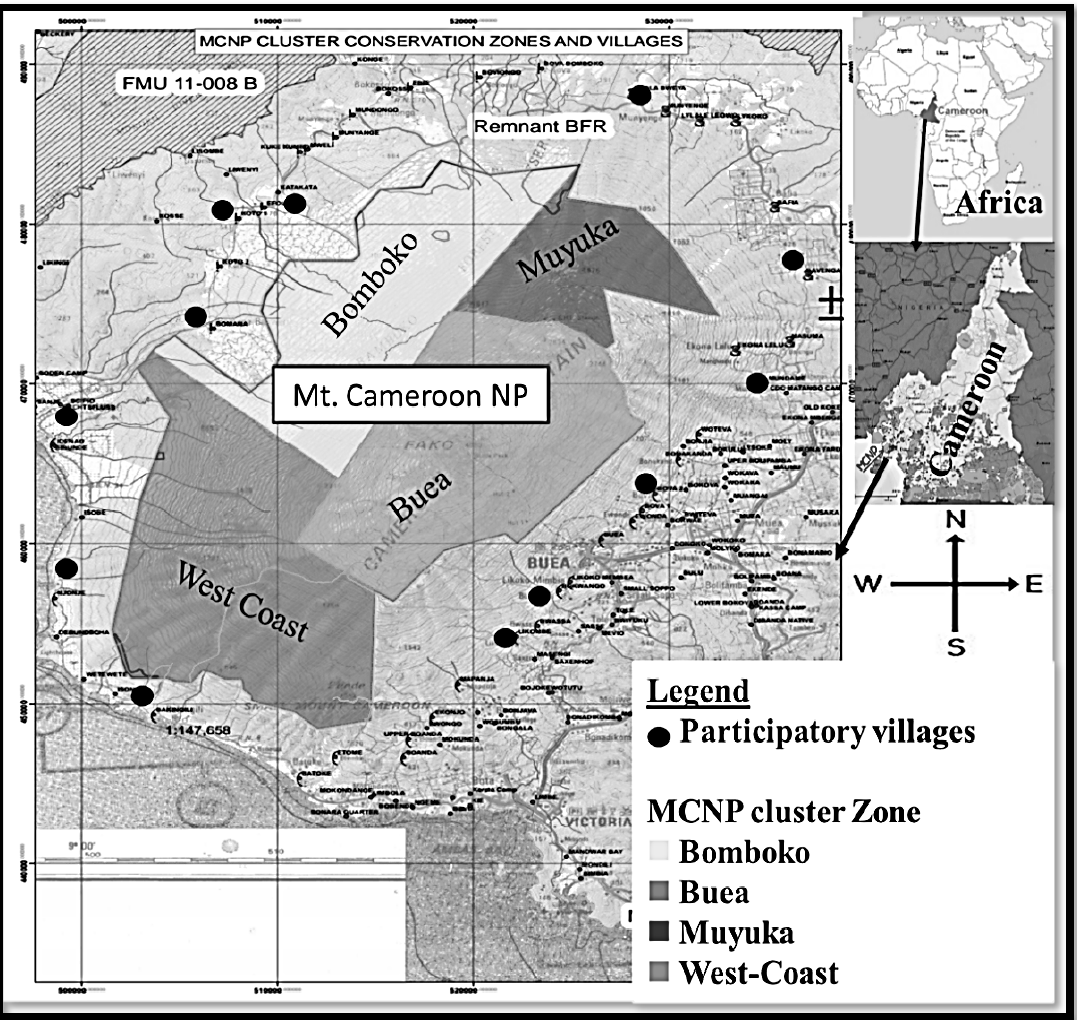
Figure 1. Map of Mount Cameroon National Park (MCNP) showing the cluster conservation zone and participatory villages involved in MCNP REDD+ project. FMU: Forest Management Unit; BFR: Bomboko Forest Reserve.